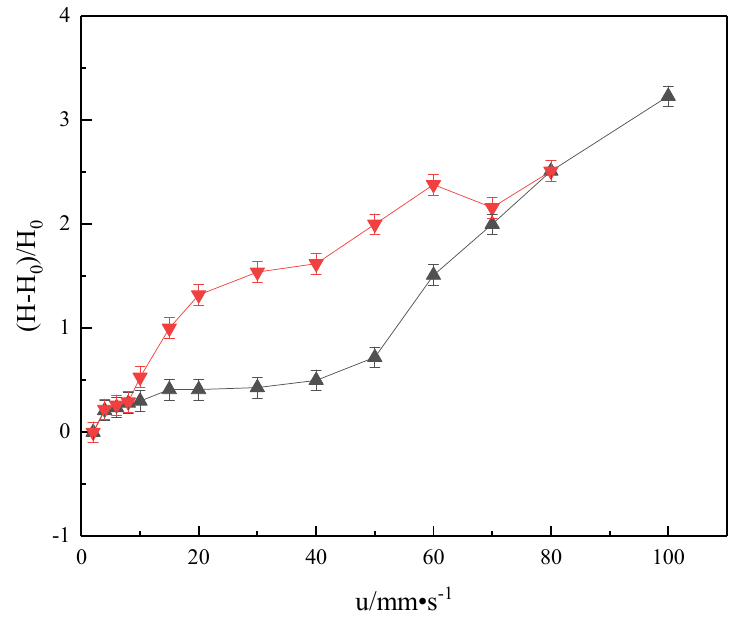
Figure 10. Bed expansion velocity curve in the silent field.